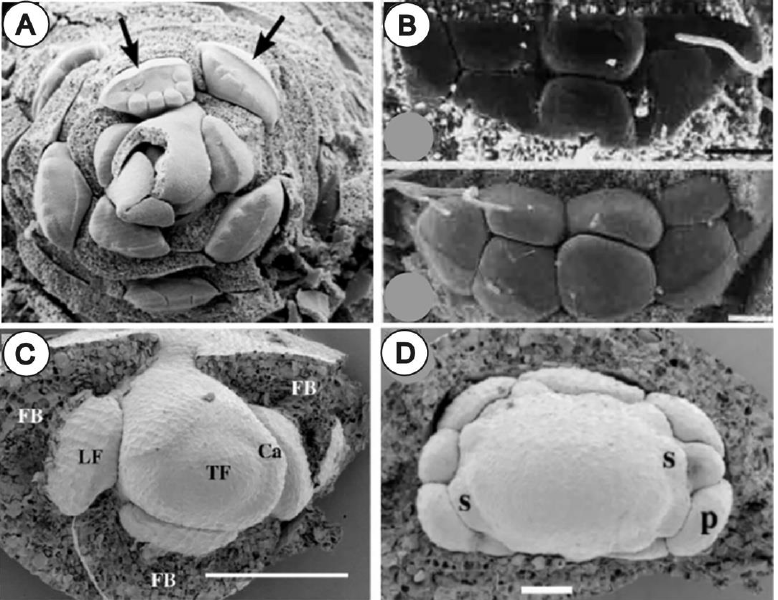
Figure 6. Examples of ellipsoidal compressed floral primordia and their mono- of disymmetric organ arrangement: ( A ) Euptelea polyandra. Note that scars are imprinted by bracts on the abaxial side (arrows) and earlier initiation of organs on adaxial side. ( B ) Notobuxus natalensis . Lateral staminate flower at two different stages of development. Note in ( A , B ) disymmetric arrangement of stamens along ellipsoidal floral primordium ( C ) Drimys winteri . Note: compressed flattened lateral flower primordia in contrast to terminal flower primordium, which is free of bract compressing forces. ( D ) Developing lateral flower primordium of Drimys showing its disymmetry (ellipsoidal flower base). In Drymis , lateral flowers have fewer organs than the radial terminal flower. Abbreviations: FB, floral bract; LF, lateral floral meristem; TF, terminal flower; Ca, calycine calyptra. Bar in B, C = 100 µm, D = 50 µm. (( A ) reproduced from Endress, 2008; ( B ) from Von Balthazar and Endress, 2002; ( C , D ) from Doust, 2001 with permission). [7,23,24].